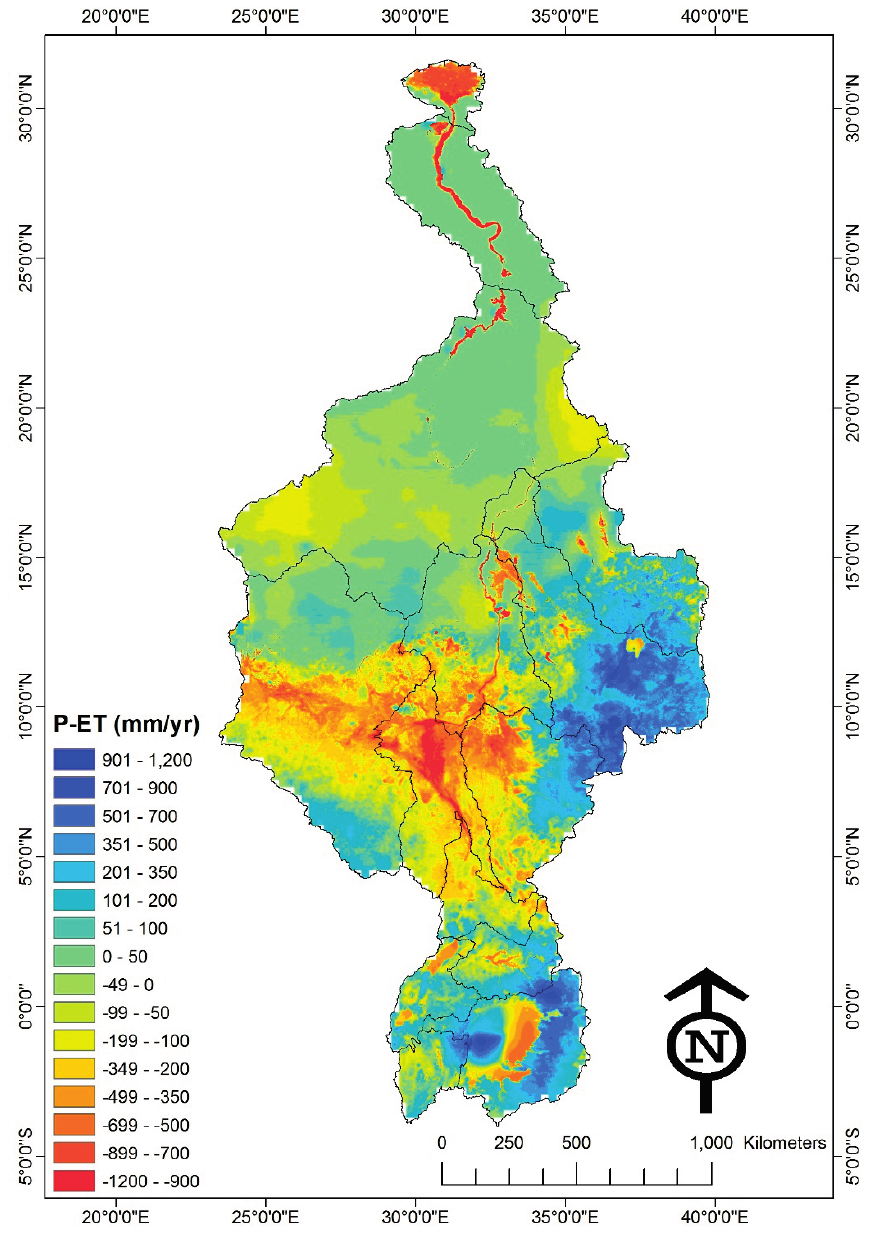
Figure 5. Water production areas (P > ET) and net water consumption areas (ET > P) for the Nile basin over the period 2005–2010. Lateral transport of water occurs from positive to negative areas, also non-conventionally via floods and groundwater